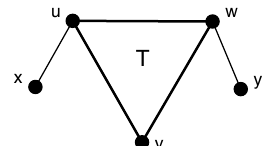
Figure 4: A triangle with two free